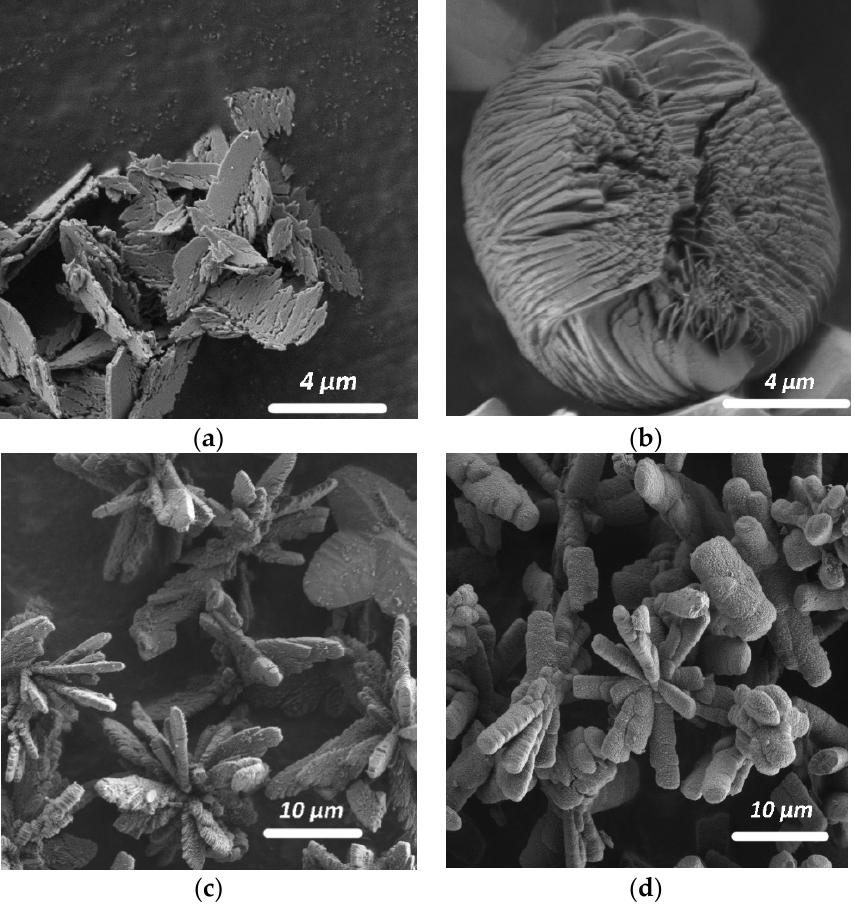
Figure 3. Morphology of whewellite crystals and their intergrowths synthesized from solutions of various composition: ( a ) without additional additives (Synthesis 1); ( b ) with the addition of K + , Mg 2+ , SO 42 − ions and citric acid (Synthesis 29); ( c ) with the addition of K + , Mg 2+ , Fe 3+ , SO 42 − , PO 43 − ions (Synthesis 3); and ( d ) with citric and fumaric acids and K + , Mg 2+ , Fe 3+ , SO 42 − , PO 43 − ions (Synthesis 32).